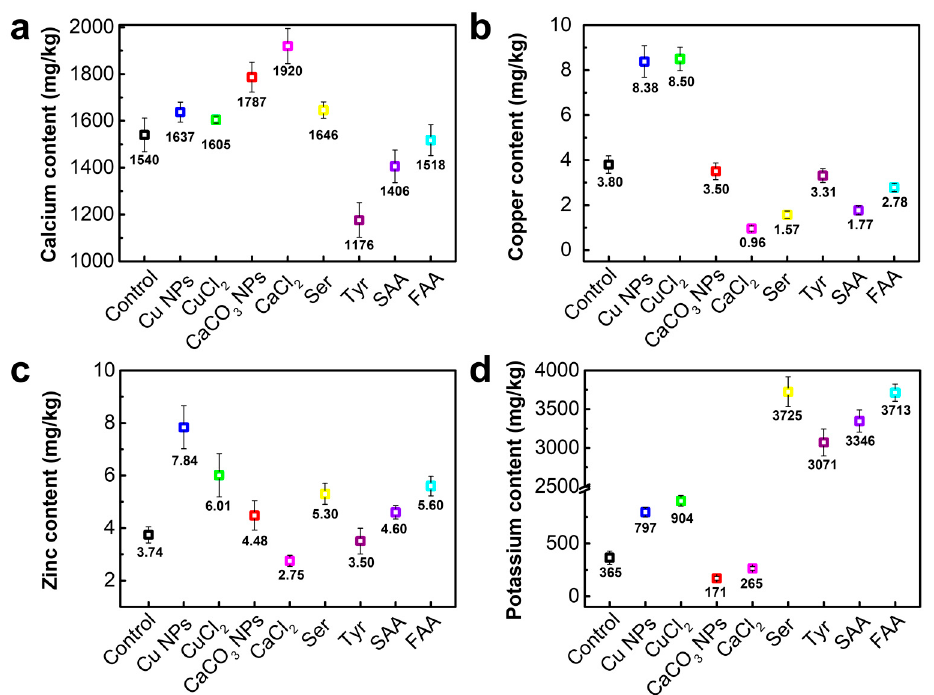
Figure 1. Distributions of four metallic elements in silk fibers. ( a ) Calcium content, ( b ) Copper content, ( c ) Zinc content, ( d ) Potassium content. The X axis is silk fiber samples obtained from different diet additives and the control is the normal silk obtained from the traditional diet without any additives. Data are mean ± sd. (Ser = serine, Tyr = tyrosine, SAA = sericin amino acid, FAA = fibroin amino acid).